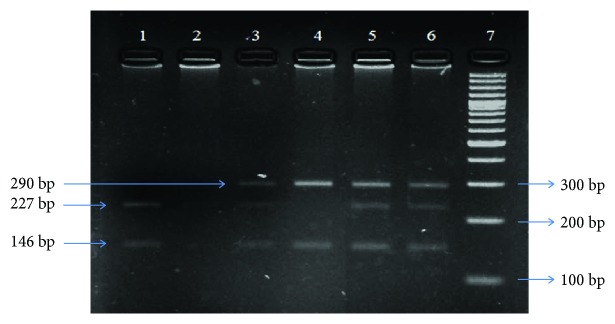
Representative gel showing PstI-digested amplicons of XPD codon 751 run on 3% agarose gel. Lane 7: 100 bp DNA ladder. Lane 4: 146 bp and 290 bp Lys/Lys genotype. Lanes 3, 5, and 6: 146 bp, 227 bp, 290 bp, and 63 bp Lys/Gln genotype. Lanes 1 and 2: 146 bp, 227 bp, and 63 bp Gln/Gln genotype.